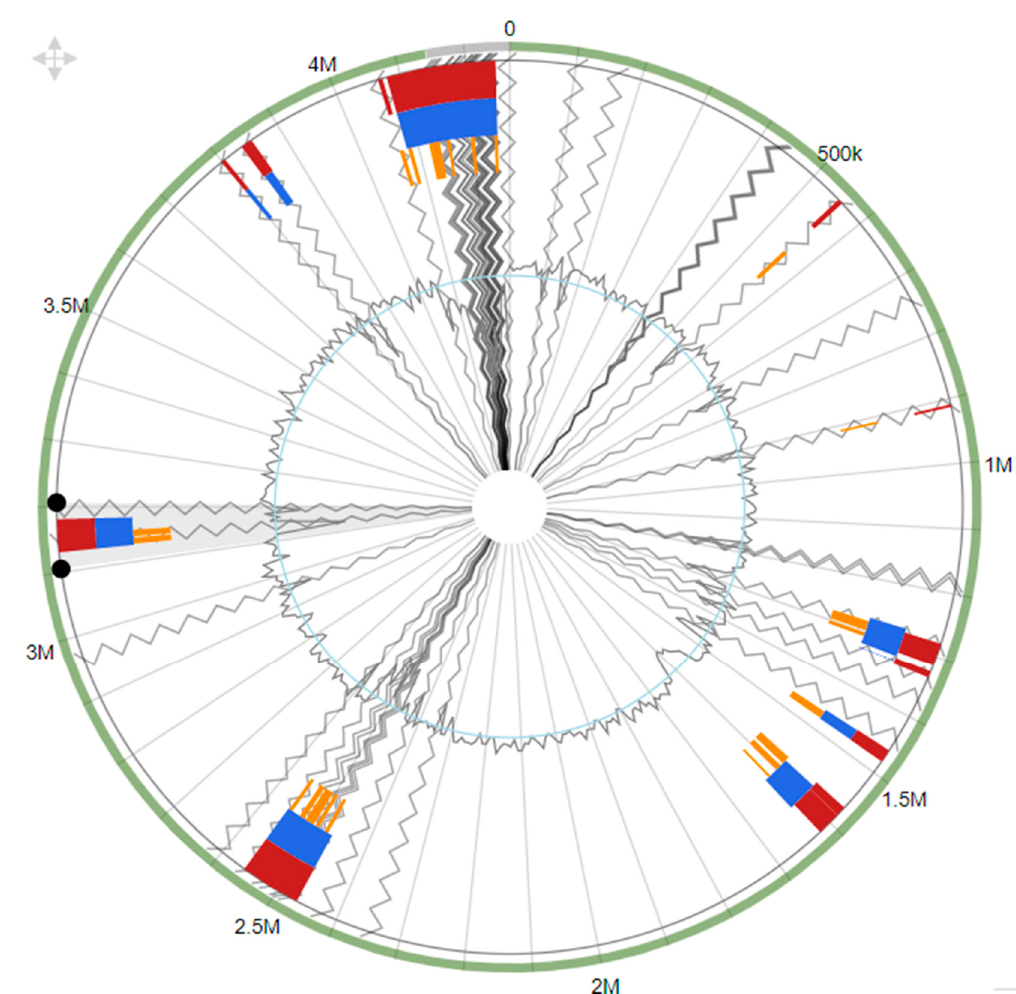
Figure 8. Genomic islands predicted by Integrated (red), IslandPath-DIMOB (blue), SIGI-HMM (orange), and contig boundary (grey lines).